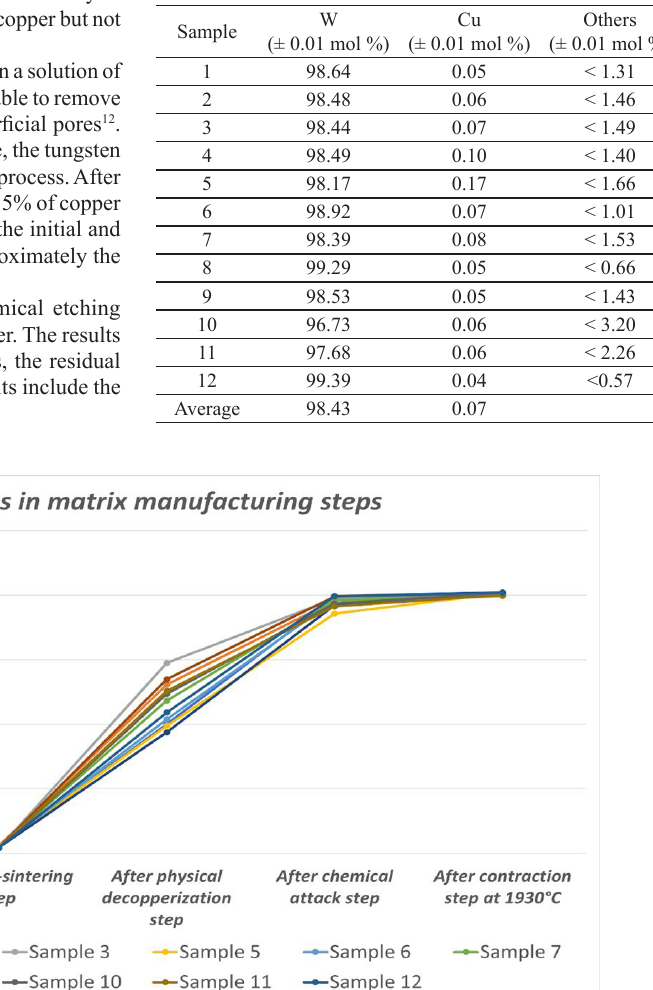
Table 3. Chemical composition of cathode pellet after chemical etching obtained by an EDX analysis.